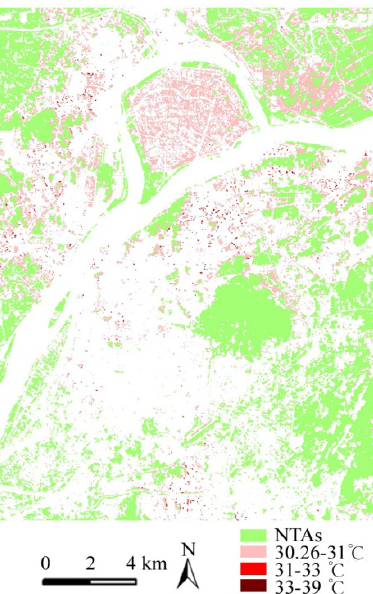
Figure 2. The pattern of HTAs levels and